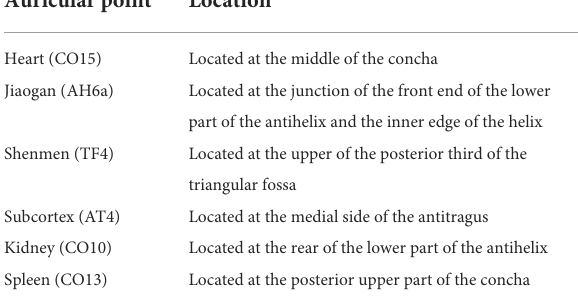
TABLE 4 Locations of auricular